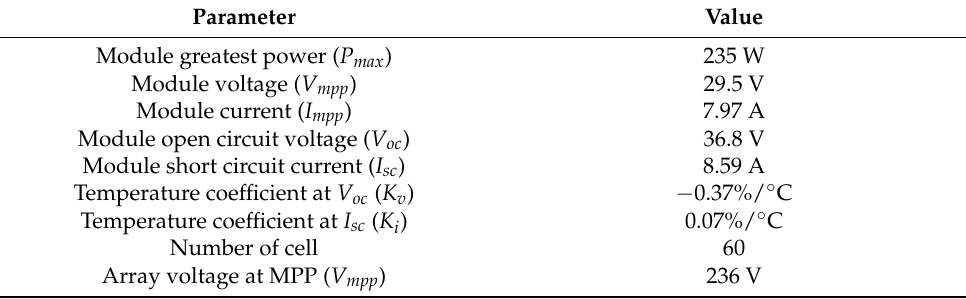
Table 1. Characteristic of PV module at standard test condition